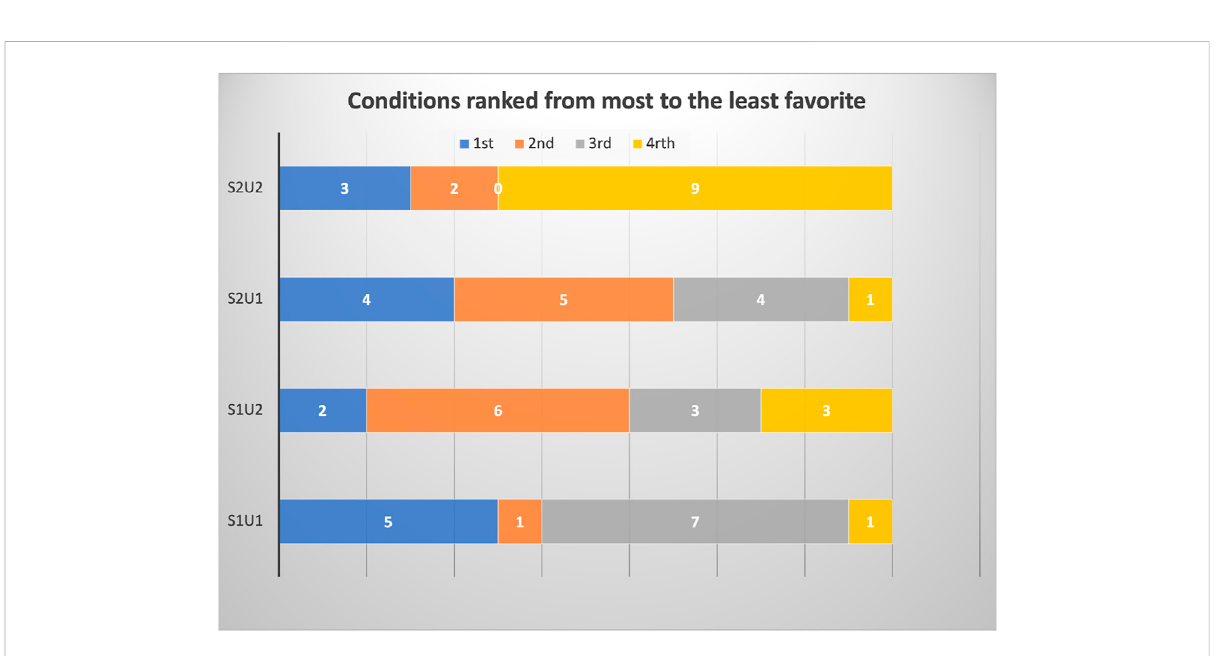
FIGURE 10 Participants ’ rankings from the most to the least favorite